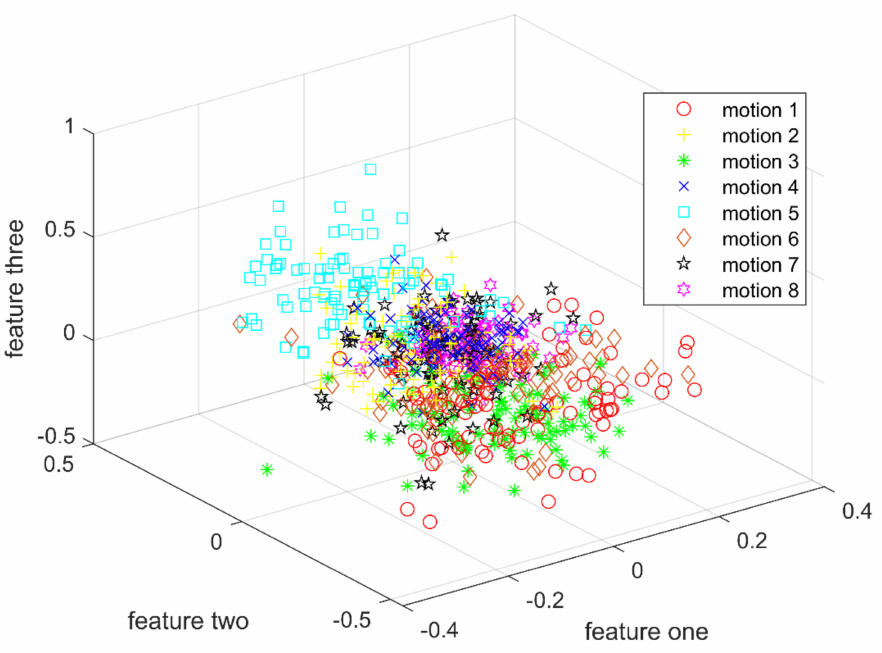
Figure 6. The first three features of the eight motions of